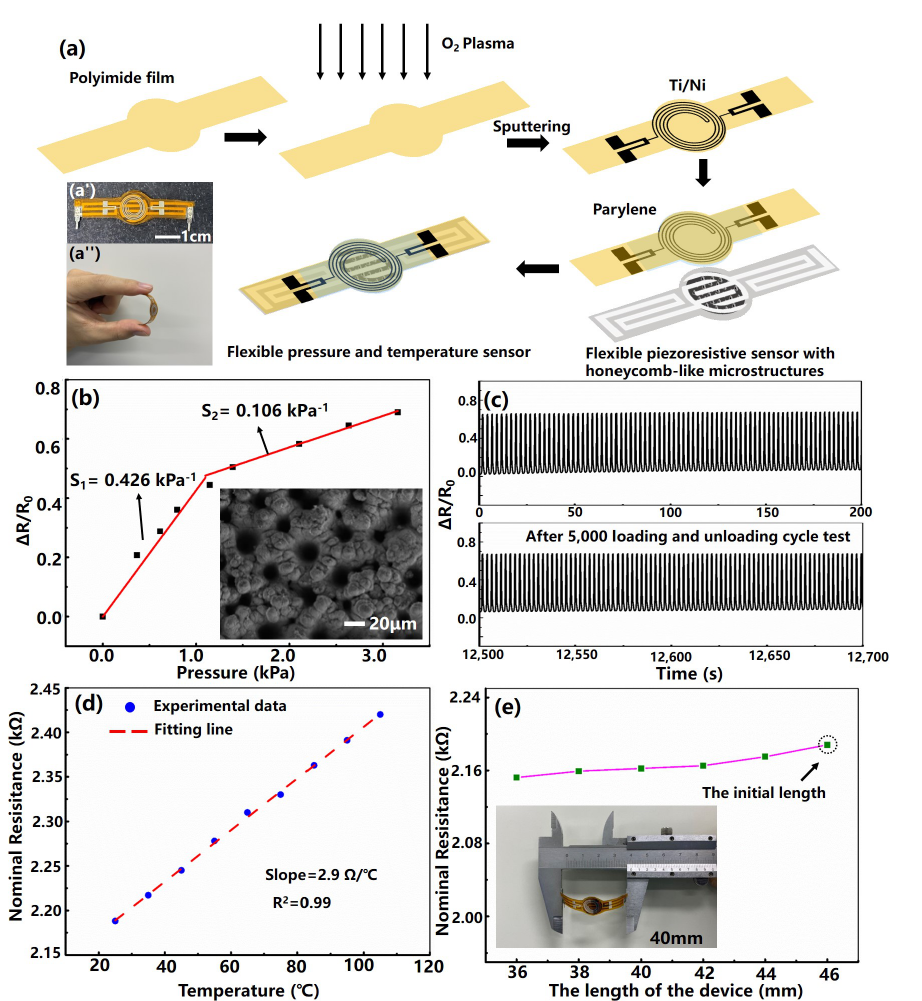
Figure 1. ( a ) Schematic of the preparation procedure for flexible pressure and temperature sensor with honeycomb-like architecture. Insets: ( a’ ) Photograph of the flexible sensor taken by a digital camera. ( a” ) The photograph of the fabricated device under bending. ( b ) Relative resistance changes under increasingly applied pressure. Inset: SEM image of the filament-processed silicon mold. ( c ) The stability cycling test of the pressure sensor under the pressure of 3 kPa. ( d ) The nominal resistance change versus the applied temperature. ( e ) The nominal resistance change of the temperature sensor under different bending states. Inset: Schematic diagram of the device length under a specific bending